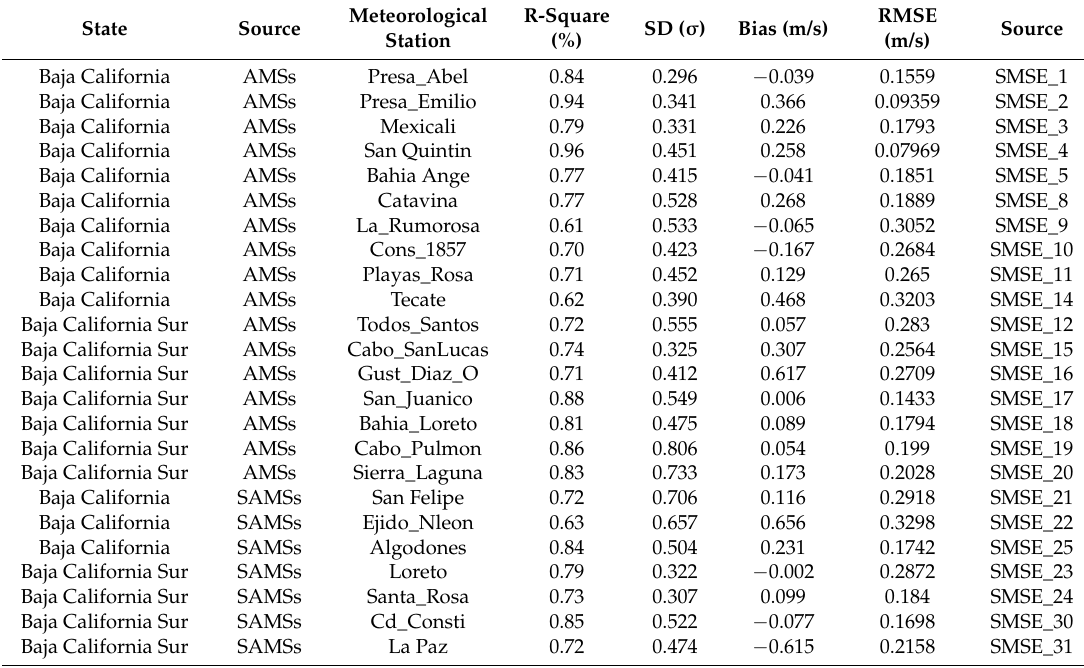
Table 2. R-Square, Bias and RMSE of AMSs, SAMSs vs SMSE Data.